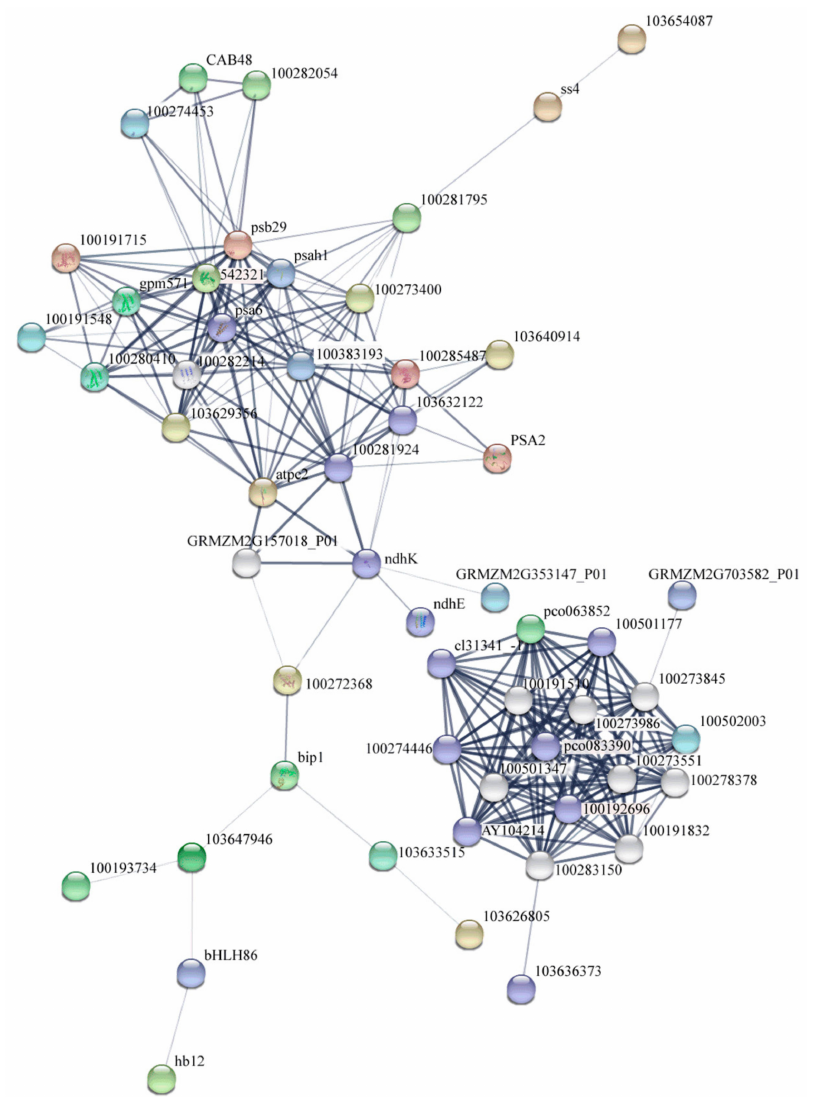
Figure 10. The string network of proteins (encoded by the di ff erentially expressed genes (DEGs)) involved in senescence signaling pathways.